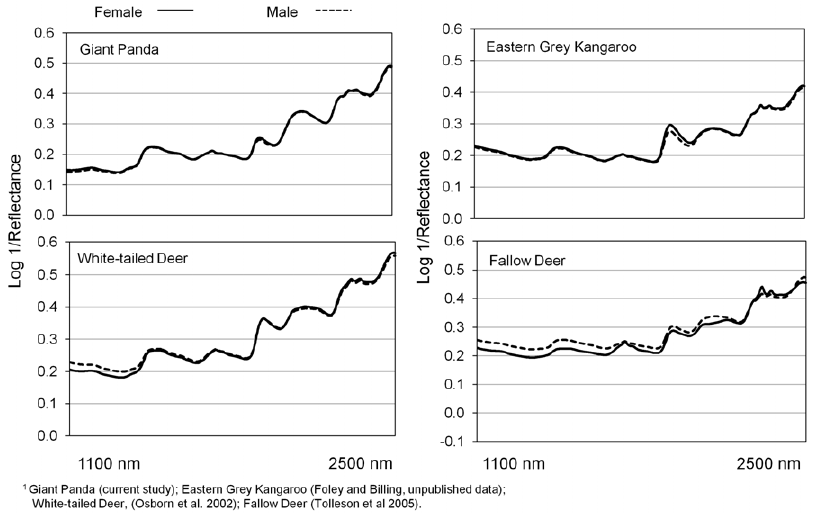
Figure 3. Average fecal near infrared spectra (log 1/reflectance, derivative=0, gap=0) from male and female animals of four different herbivore species.